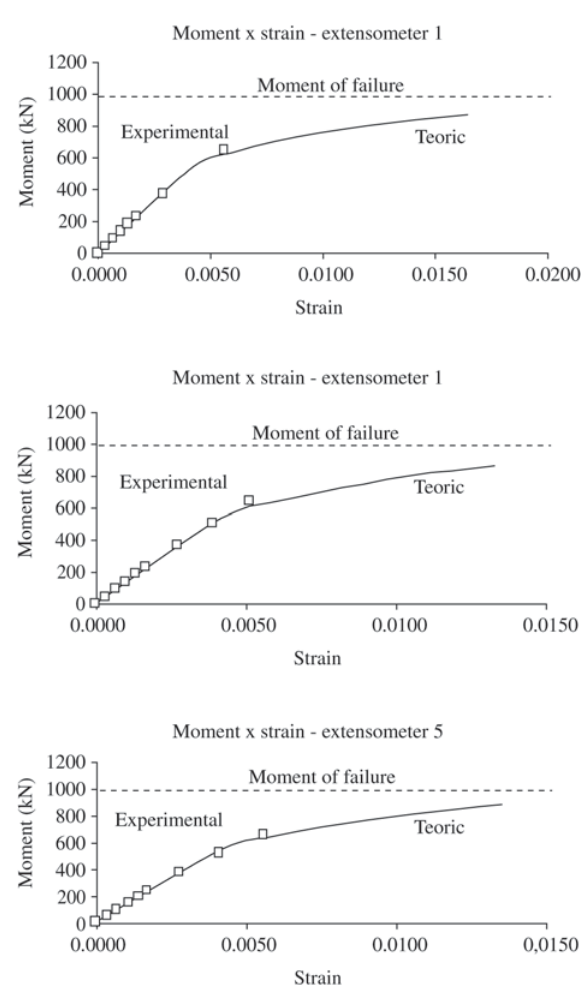
Figure 12. Moment × strain - Pinus beam 03 section (6 × 12